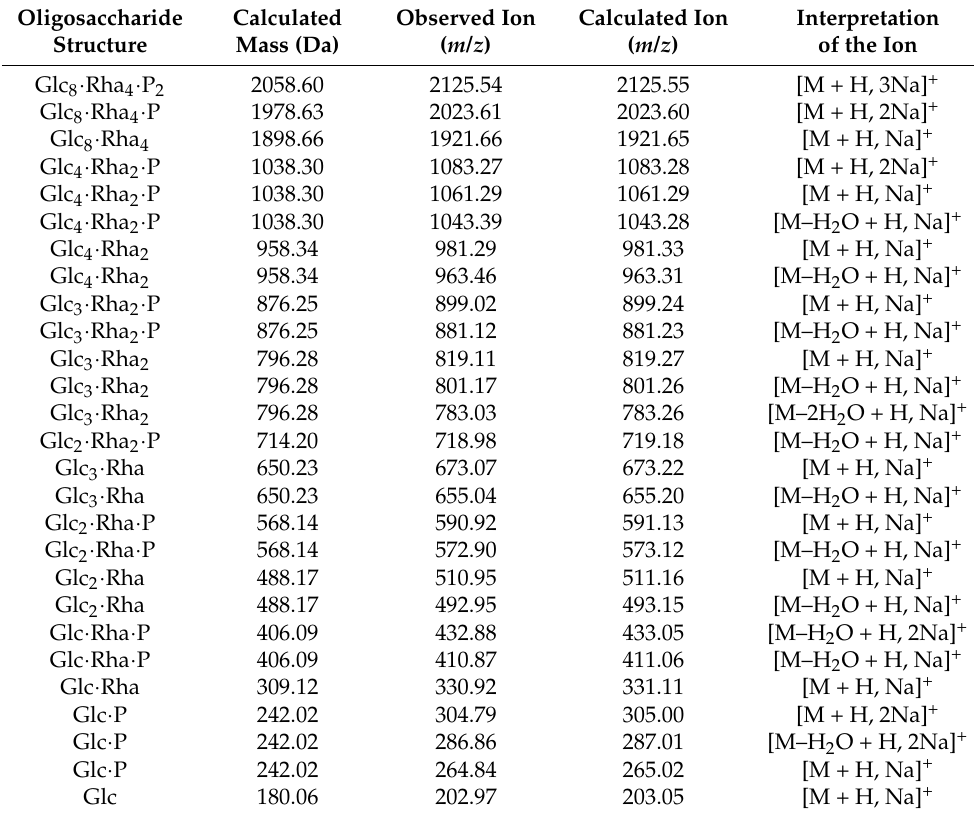
Table 2. Interpretation of positive ion mode MALDI-TOF mass spectra of the partially hydrolysed EPS (Figure 4A) and the MS/MS fragmentation of the hexasaccharide represented by the ion at m / z 1061.29 (inset structure) (Figure